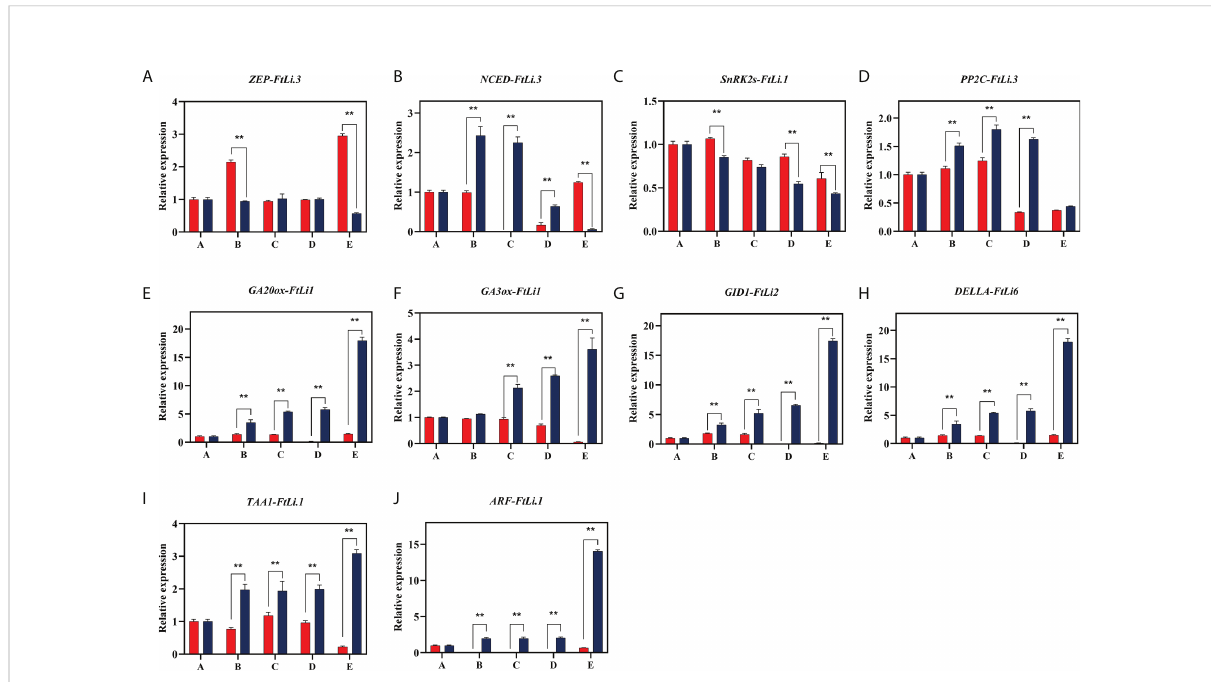
FIGURE 6 The RT-qPCR validation of the expression levels of genes related to endogenous hormones present in F. taipaiensis . The values presented are the means + SD of three biological replicates. The transcript IDs and the primers of each gene are listed in Supplementary Tables 2, 12. A(ZEP, zeaxanthin cyclooxygenase), B(NCED,9-cis-cyclooxygenase lyase), C(SnRK2s,Snf1 ‐ related protein kinases 2), D(PP2C,PP2C phosphatases), E (GA20ox,GA 20-oxidase), F(GA3ox,GA 3-oxidase), G(GID1,GIBBERELLIN INSENSITIVE DWARF 1), H(DELLA, DELLA protein), I(TAA1,tryptophan aminotransferase 1), J(ARF, AUXIN RESPONSE FACTOR). ** indicate signi fi cant difference (P <